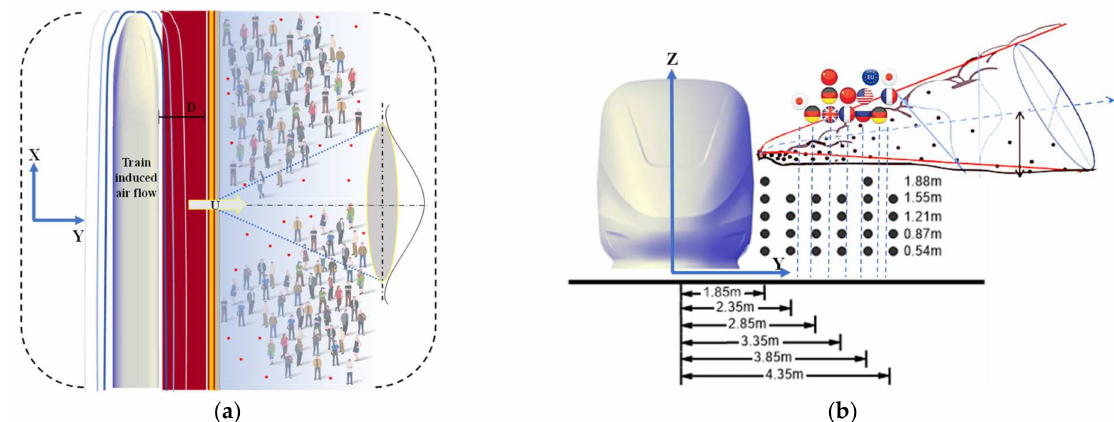
Figure 4. ( a ) Virus spread by train-induced wind and definition sketch; ( b ) Monitor points for train-induced wind velocity around the train (flag icons: minimum safe distances from passing trains for different